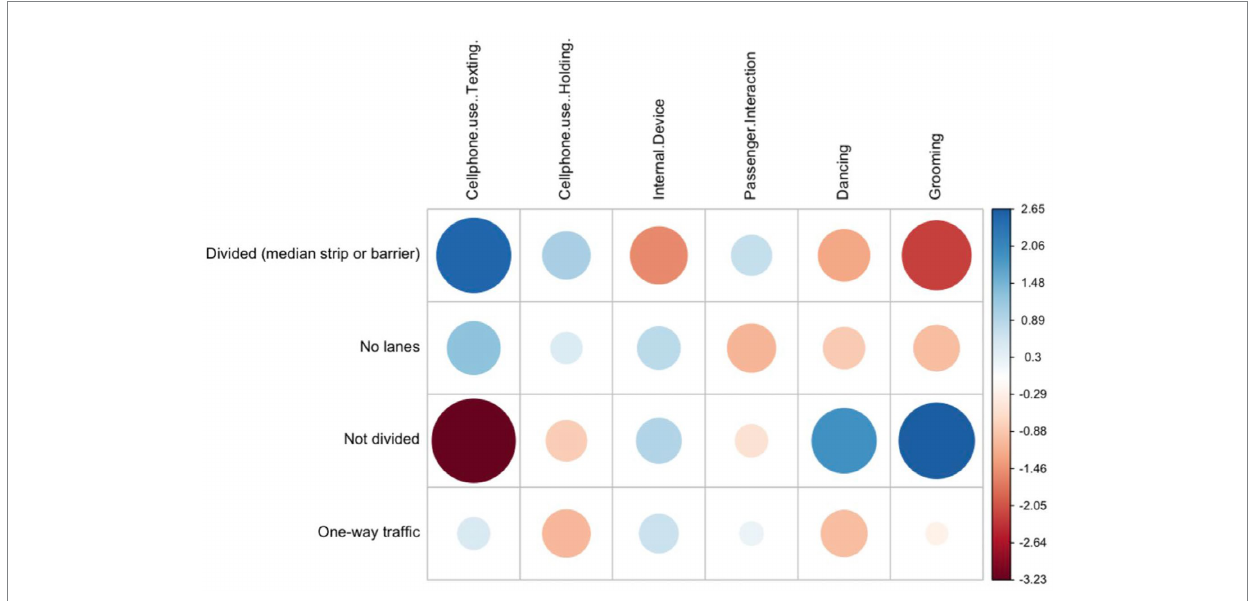
FIGURE 4 Pearson residuals for roadway design and secondary task